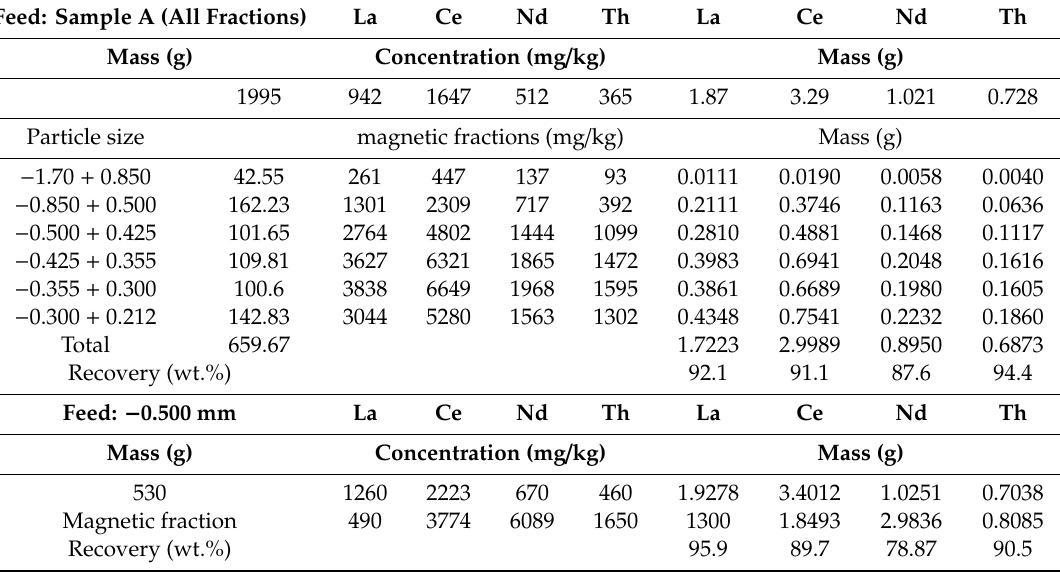
Table 5. REE distribution and recovery of REE and Th in the magnetic products of each particle size of the A-mixed sample and the undersize 0.500